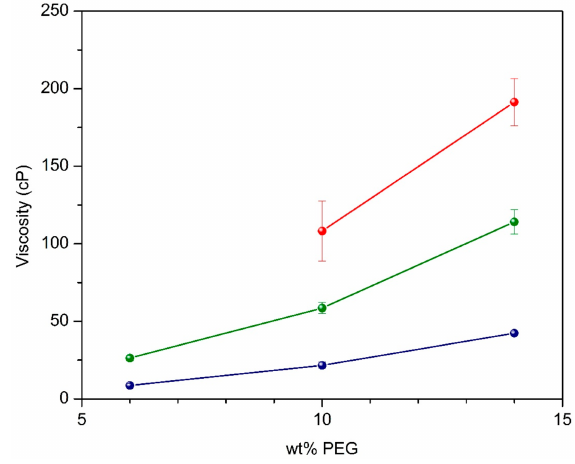
Figure 1. Viscosity measurements of various CB and PEG mixtures, where the blue data is without CB, green is with 3 wt % CB, and red is with 5 wt %